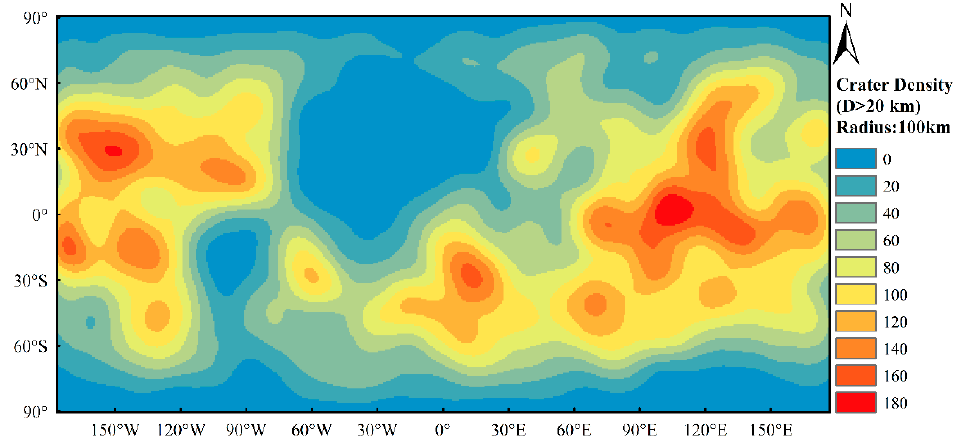
Figure 13. The density map of lunar impact craters (D > 20 km).